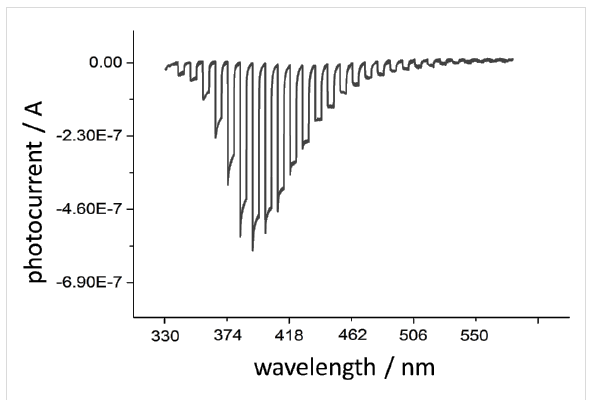
Figure 6: Photocurrent generated at the [CrF 5 (H 2 O)] 2 − @TiO 2 elec- trode as a function of the wavelength of the incident light, recorded at constant potential of 500 mV vs Ag/AgCl. The spikes originate from the opening and closing of the